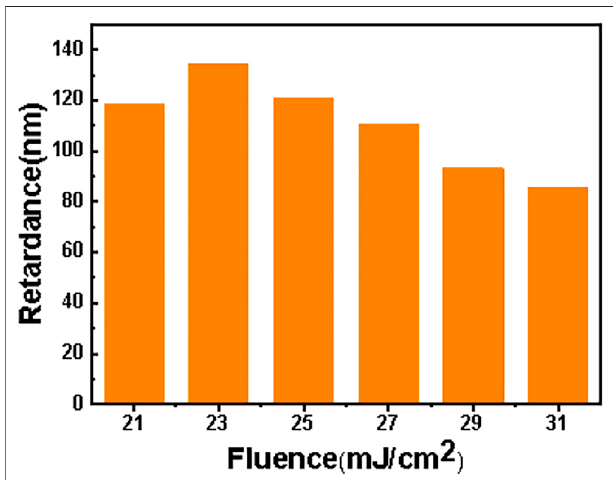
FIGURE 5 | Variation of the phase retardance with laser fl uence.